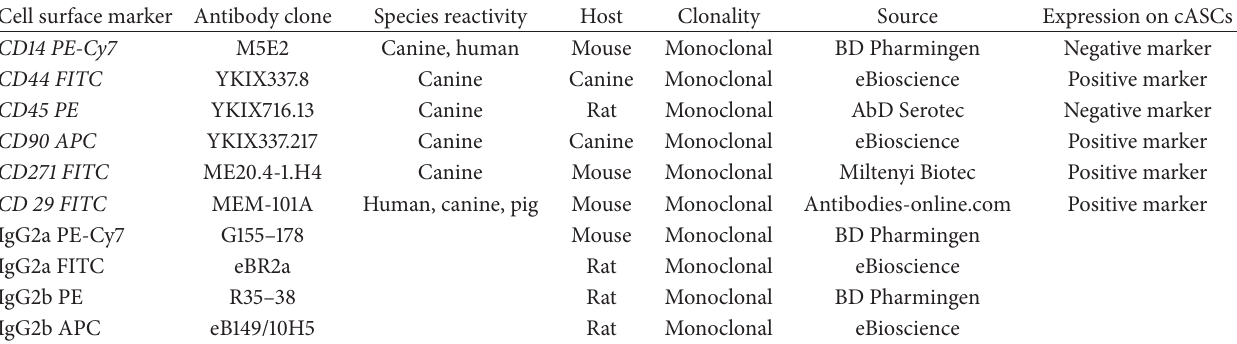
Table 1: Antibody panel used for flow cytometry